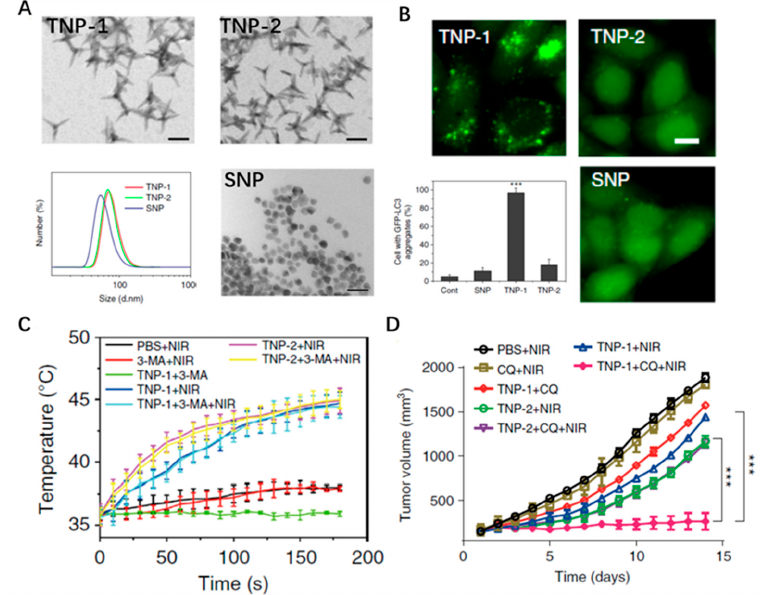
Figure 4. Enhanced PTT of TNP-1 for drug-resistant cancer in combination with autophagy inhibitors 3-MA or CQ. ( A ) TEM images of CuPd TNP-1, TNP-2, and SNP and size distribution of CuPd nanoparticles in aqueous solution as measured by dynamic light scattering (DLS). ( B ) Fluorescent microscopy images of EGFP-LC3/HeLa cells treated with PBS (control) or 10 µ g mL − 1 of CuPd nanoparticles for 24 h. Scale bar, 10 µ m. The right panel shows the quantified results for the percentage of cells containing at least five EGFP-LC3 dots. Mean ± s.e.m. n = 5. *** p < 0.001. ( C ) The tumor-site temperature changes recorded during NIR irradiation for the various times, 24 h after the indicated PTT treatment. ( D ) Changes of mice in the various treatment groups during the 15-day therapeutic period. Doses used: TNP-1 or TNP-2, 1.5 mg kg − 1 ; CQ, 25 mg kg − 1 ; 3-MA, 100 µ mol kg − 1 . Mean ± s.e.m. n = 5. *** p < 0.001. Student’s t -test (adapted from Reference [48]